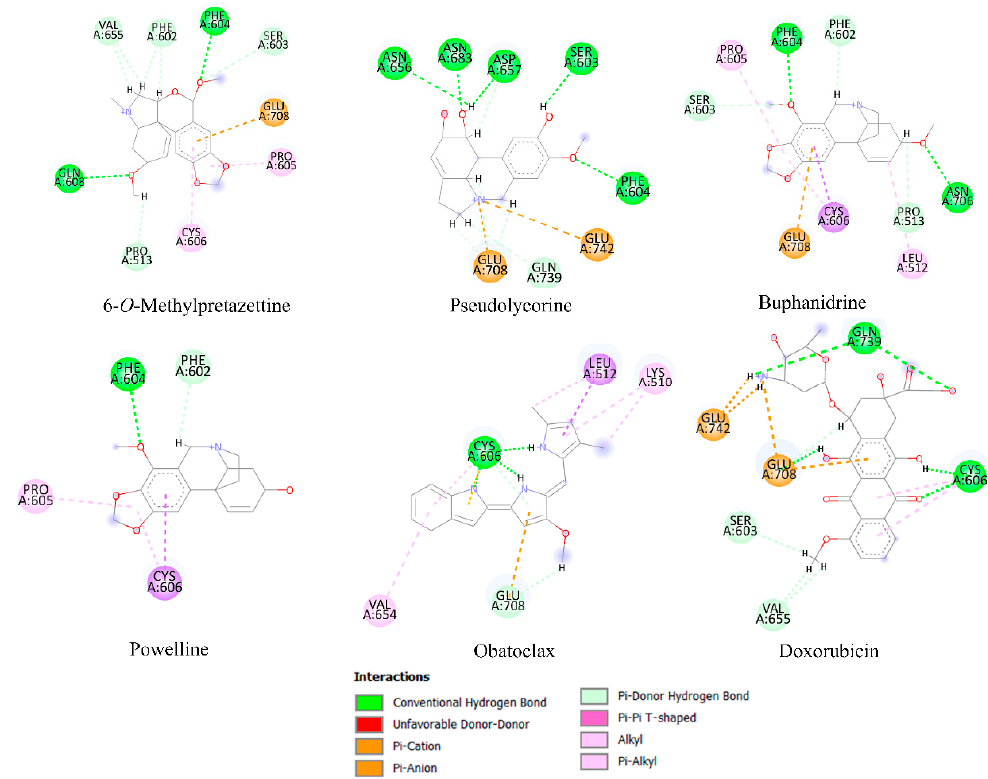
Molecules 2023 , 28 , x FOR PEER REVIEW 11 of 21 Figure 5. Principal interactions located by the molecular docking experiments between the ligands 11,12-dehydroanhydrolycorine, deacetylcantabricine, norlycoramine, and powelline with Bcl-xL protein.